Question: Describe this figure in one sentence.
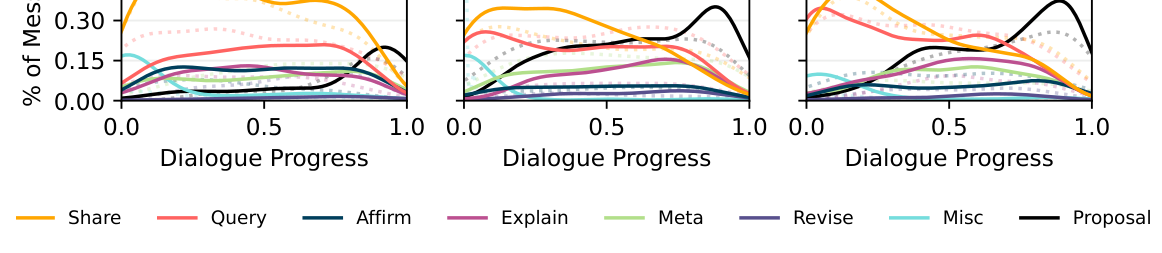
Answer: Kernel density estimates of message types in human-human (solid) and human-LM (dashed) dialogues plotted against their position within a dialogue. Message types were annotated using few-shot prompting with GPT-4 and validated by manual human annotation.